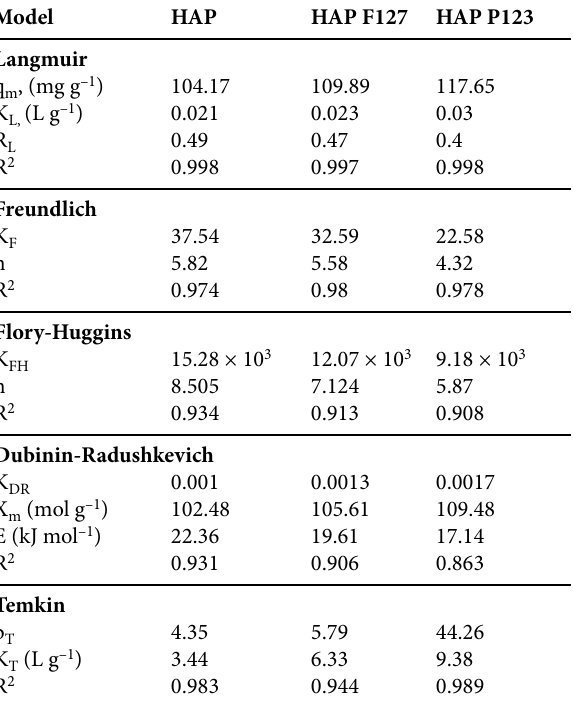
Table 3. Adsorption isotherm